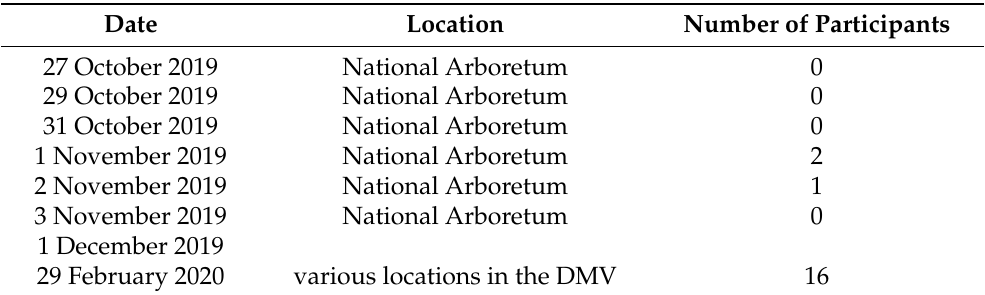
Table 2. Dates and numbers of participants for second design iteration user studies at the Na- tional